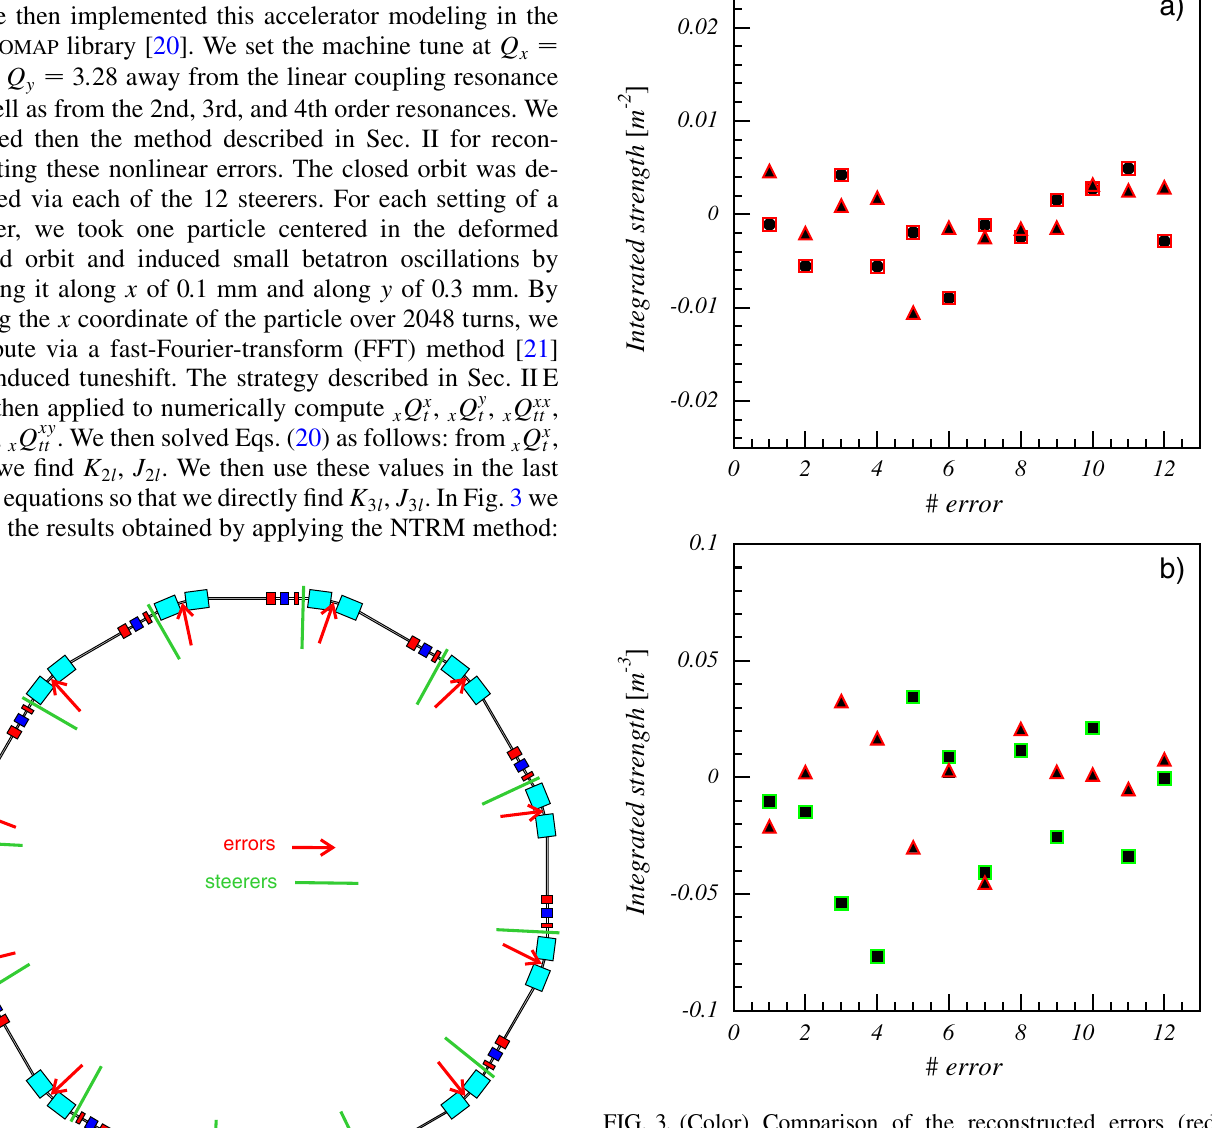
FIG. 3. (Color) Comparison of the reconstructed errors (red markers) with the error set in the SIS18 (black markers). The squared markers refer to normal components, while the triangu- lar markers refer to skew component. In (a) the comparison is shown for sextupolar errors, in (b) for octupolar errors (both solutions for K 3 l are plot: red and green squared empty